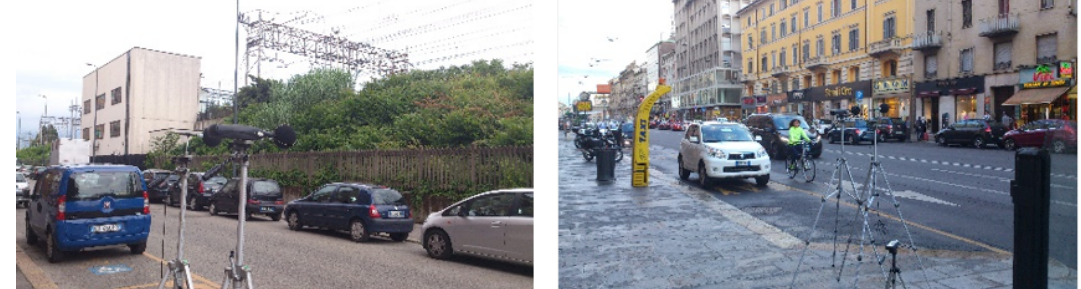
Figure 3. Examples of the recording setup installed in the urban scenario